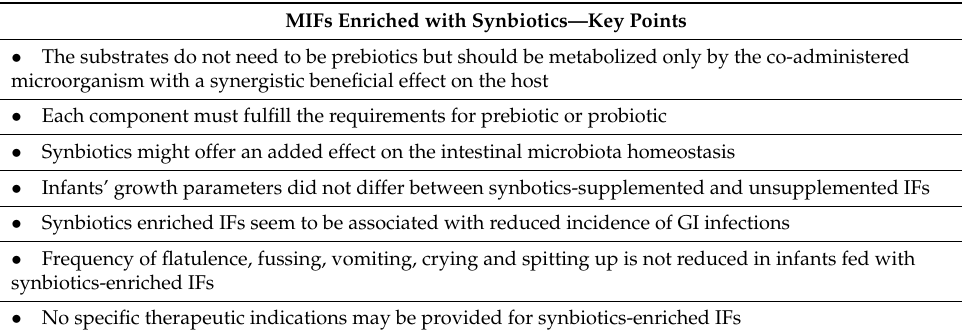
Table 5. Summary of beneficial effect of MIFs enriched with